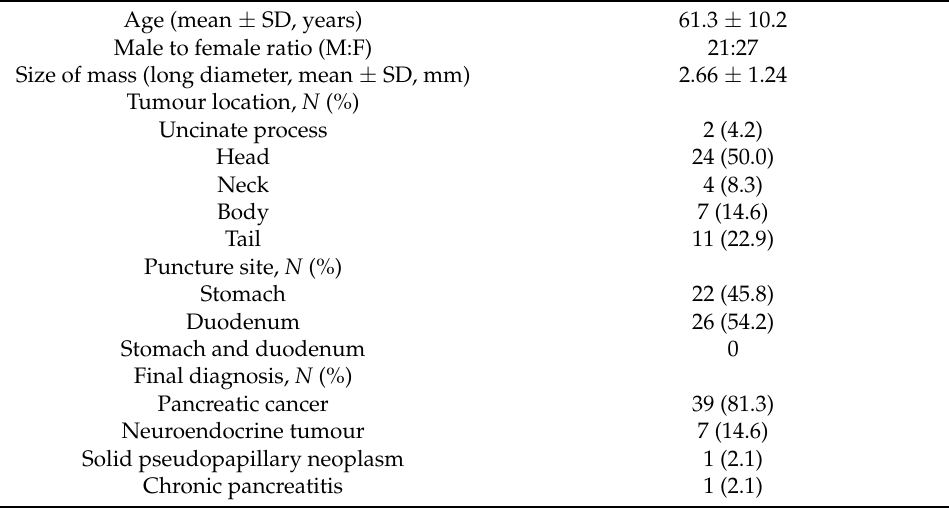
Table 5. Baseline characteristics of enrolled patients in a head-to-head comparison study between suction and non-suction (study II).